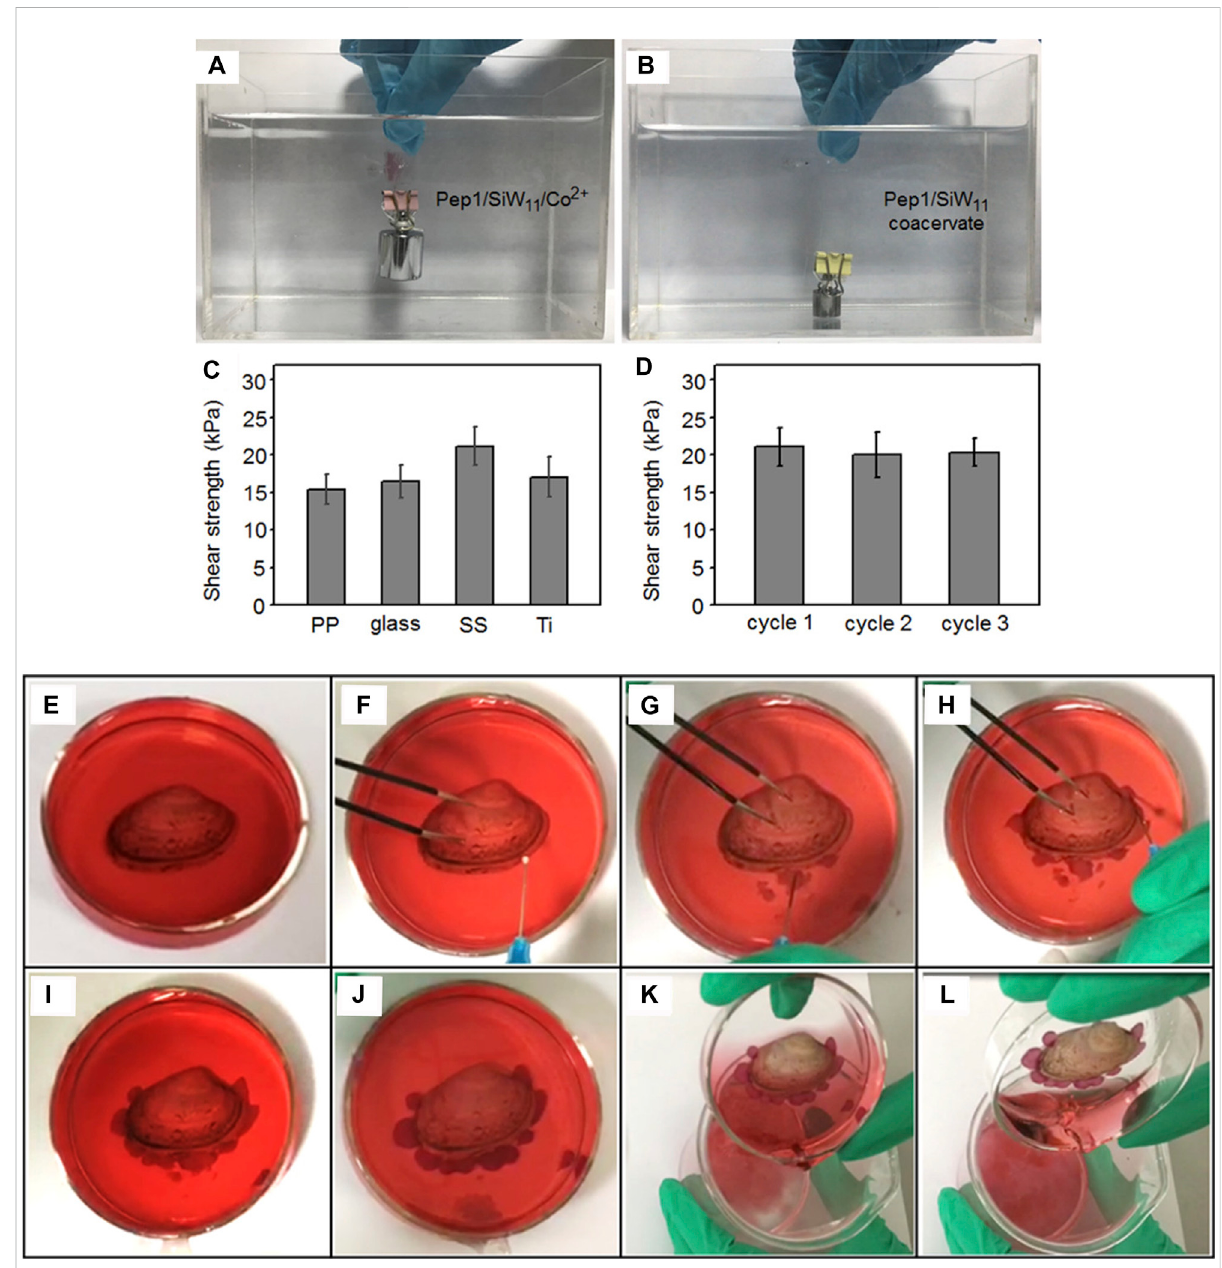
FIGURE 7 (A) UnderwateradhesionbehaviorofthePep1/SiW (B) underwater 11 /Co 2+ gel(pH=6.5)compressedbetweentwoglassslideswitha100 gload; adhesion failure of the Pep1/SiW 11 coacervate (pH = 6.5) compressed between two glass slides with a 10 g load; (C) underwater shear adhesion strengths of the Pep1/SiW 11 /Co 2+ gel bonded to different substrates (PP, glass, SS, and Ti); (D) underwater shear strength of the Pep1/SiW 11 /Co 2+ gel as afunction of the attachment/detachmentcycles; (E) shell on awatchglass containing Co 2+ aqueous solution, (F) injection of the Pep1/SiW 11 coacervate through a fi ne needle, (G) coacervate droplets being injected into the Co 2+ aqueous solution, (H) injected coacervate droplets adhering aroundtheshell, (I) dropletsafterinjection, (J) dropletschangingintothegelphaseafter30 min, (K) removingtheCo 2+ aqueoussolutionafterthegel phase was kept for 2 h, and (L) tilt test demonstrating the shell to be adhered to the original site of the watch glass. (Li et al., 2019) Copyright © 2019 American Chemical